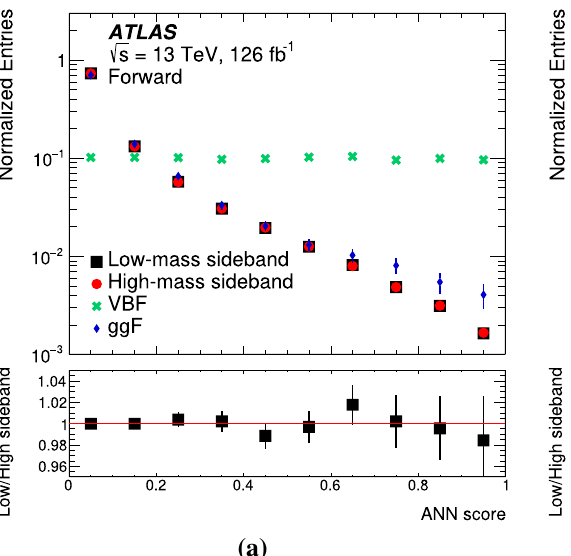
Fig. 2 Distribution of ANN output scores for the VBF signal MC events (green crosses), ggF MC events (blue diamonds) and low and high mass data sidebands (black squares, red dots, respectively) for the